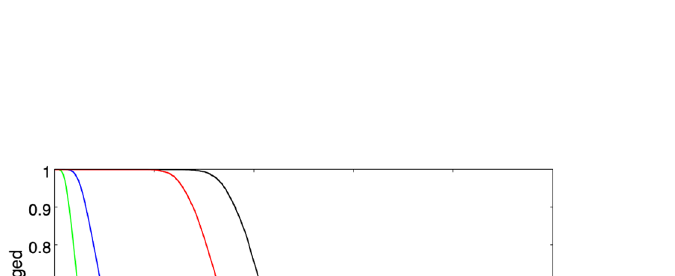
Figure 7. The number of paths that, at each time bin, reached Neumann activation delay for the detector switched off/on, respetively) or for von Neumann activation delay switched off/on, respectively), with 𝜀 = 1 ∕ N , N being the number of paths considered in the statistical sample ( 10 3 in this case), for the two detectors case and 𝛾 = 𝛾 2 . The integral of any single histogram represents the total number of paths arrived at convergence (Born Rule).